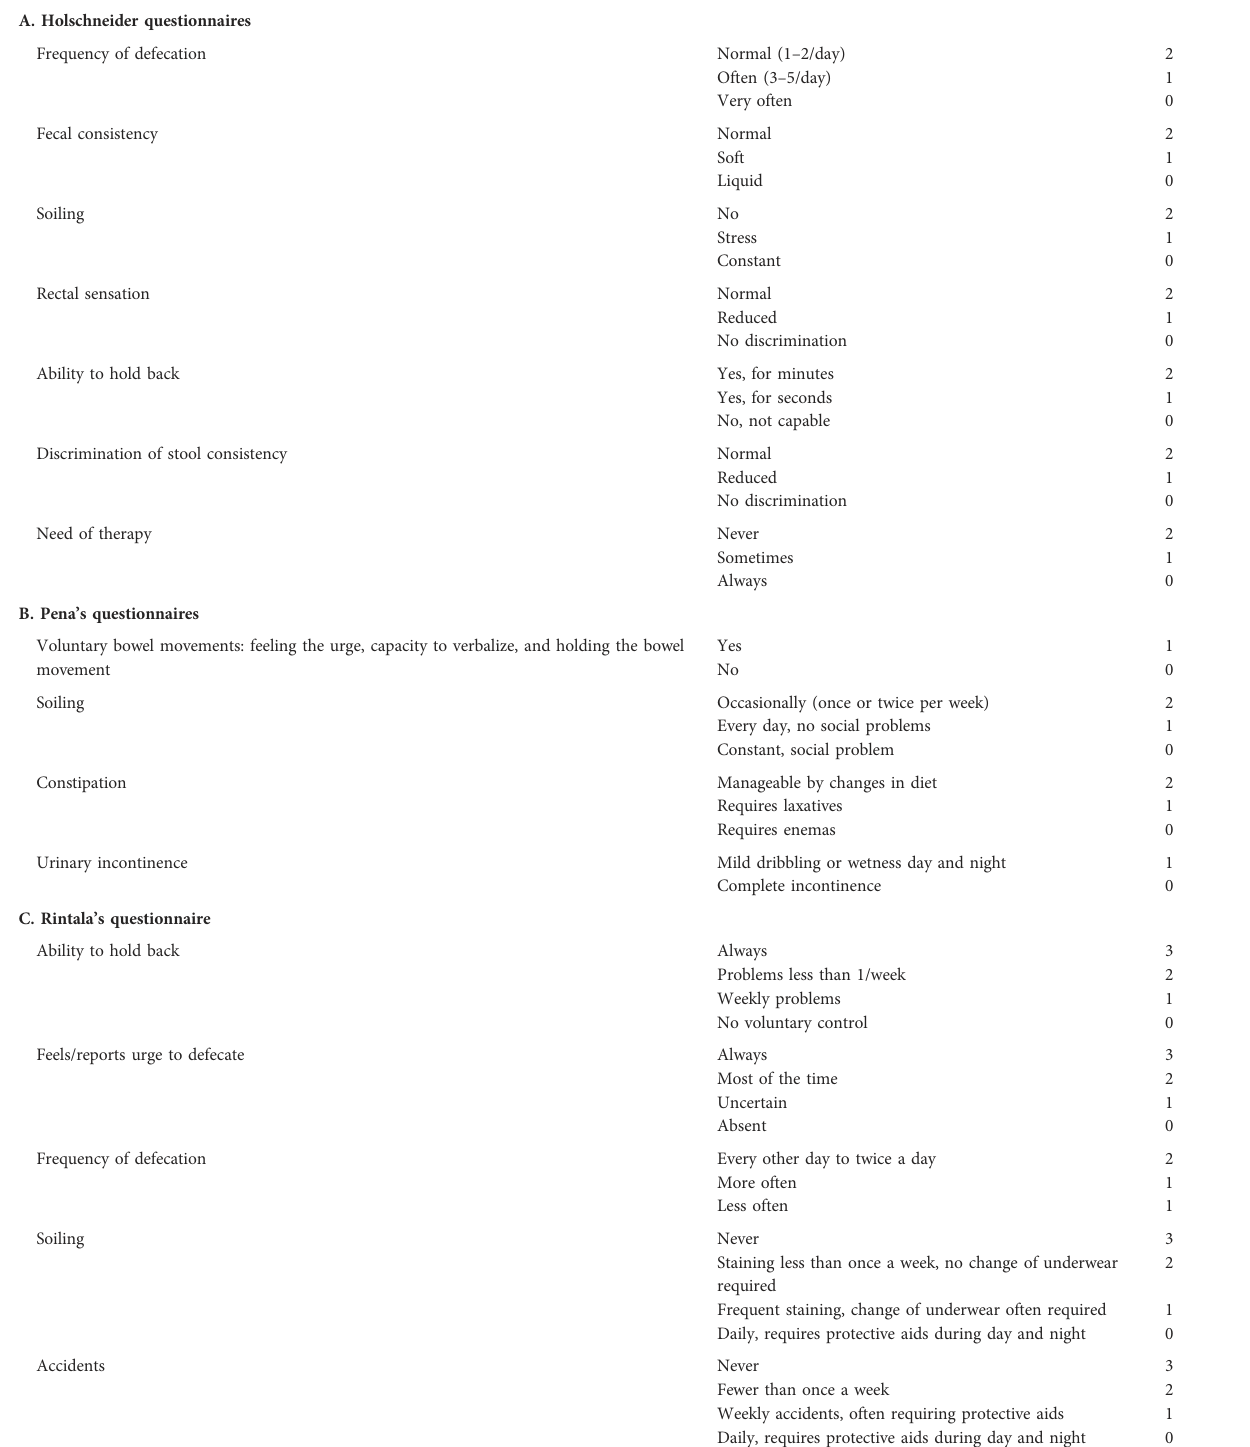
TABLE 2 The common FI scores in children and